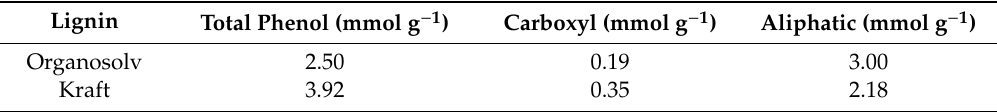
Table 1. 31 P NMR (Nuclear Magnetic Resonance)